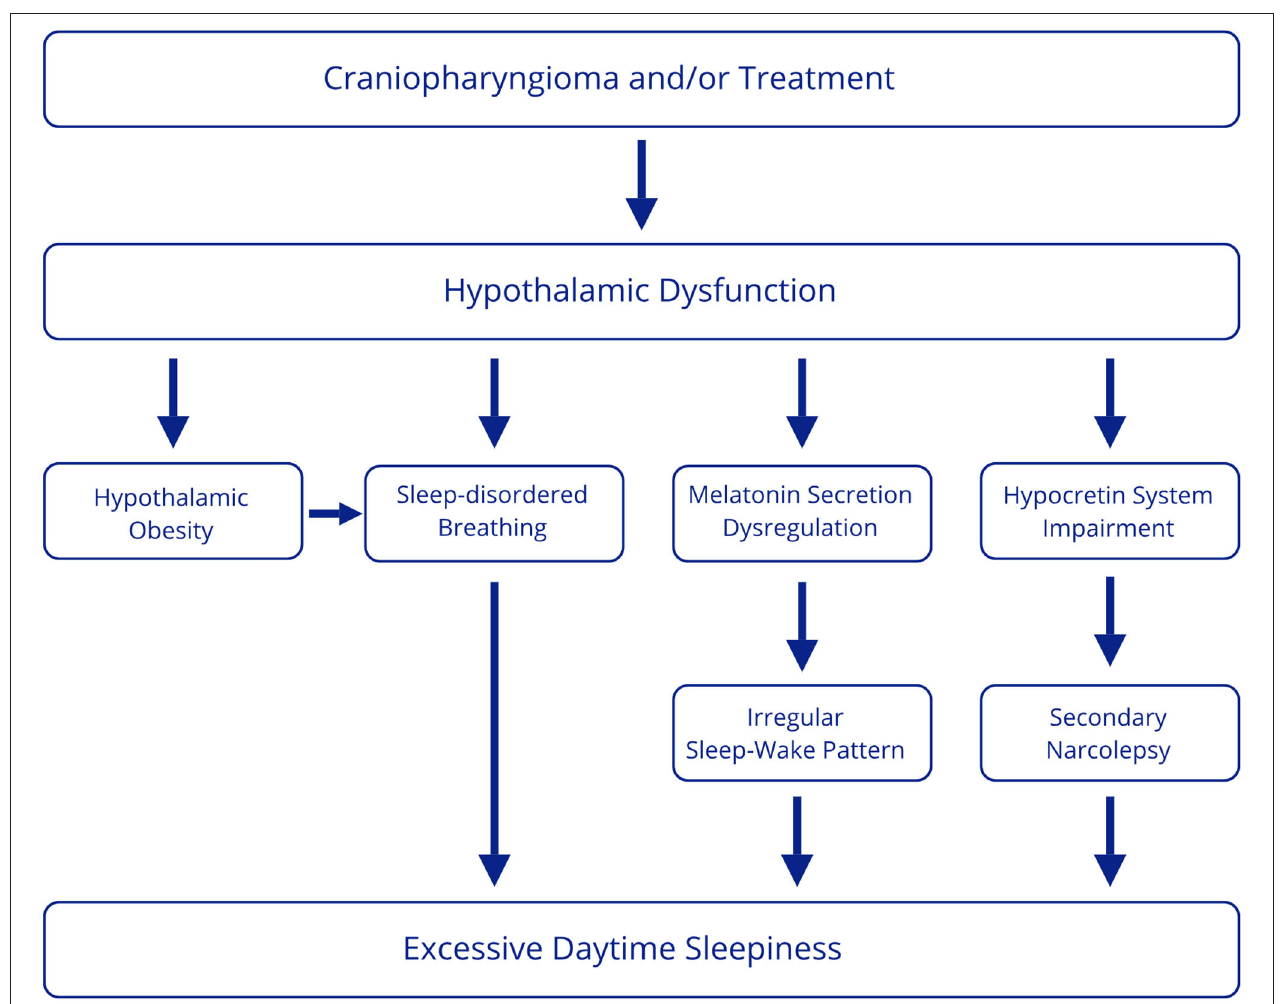
FIGURE 2 | Multifactorial origin of excessive daytime sleepiness in CP